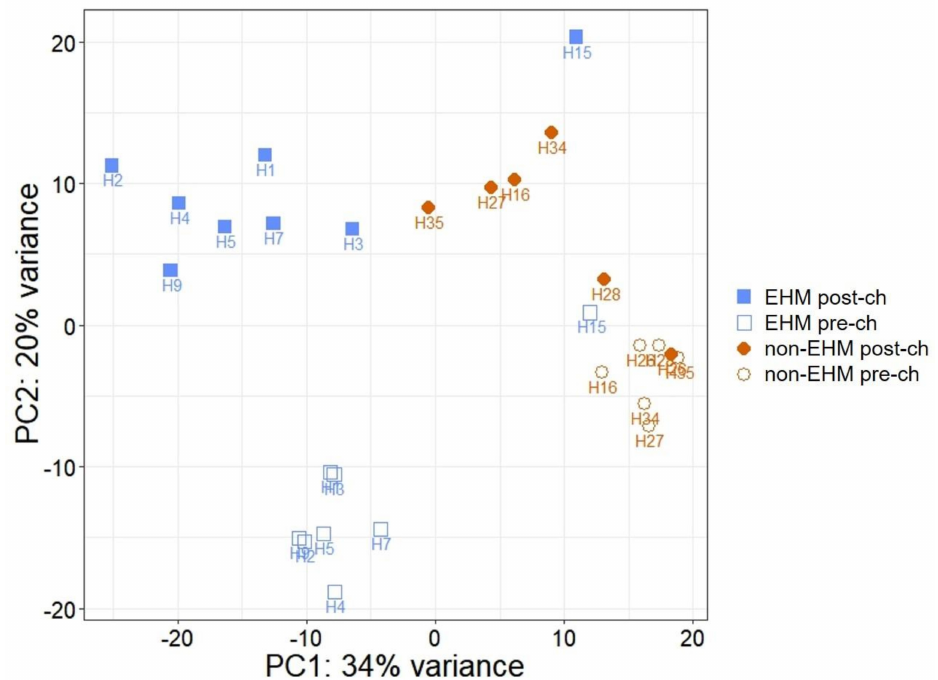
Figure 4. Principle component analysis (PCA) plot. Principle component analysis was performed on the read count data obtained after mRNA sequencing. Brown closed diamonds indicate samples from non-EHM horses post EHV-1 CH, brown open circles indicate samples from non-EHM horses prior to EHV-1 CH, blue closed squares indicate samples from EHM horses post EHV-1 CH, and blue open squares indicate samples from EHM horses prior to EHV-1